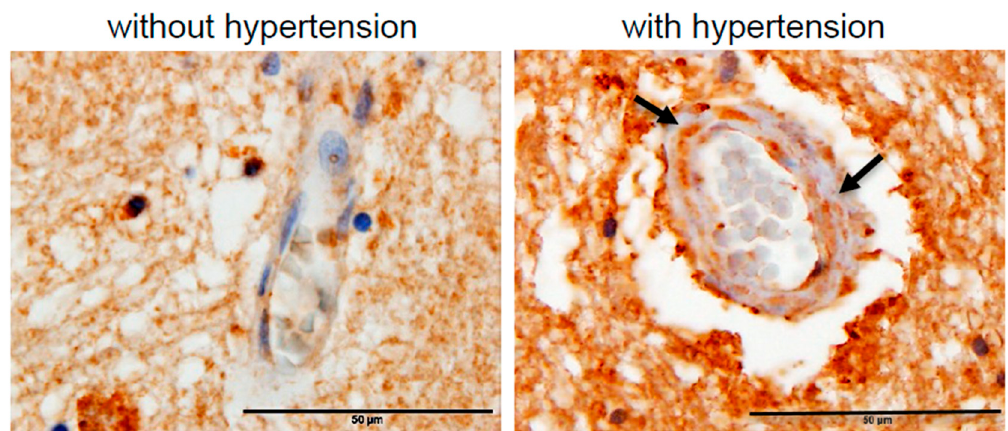
Figure 3. Immunohistochemistry for MDA. Representative immunohistochemistry results using the MDA antibody to assess the levels of oxidative stress in the brain of patients who died of ischemic stroke without hypertension or with hypertension. In patients with hypertension, the intense MDA expression is visible in the cerebral vessel walls (arrows) and the surrounding neuronal tissues. Magnifications × 400. Scale bars, 50 µ m. Representative images of n = 8 patients per